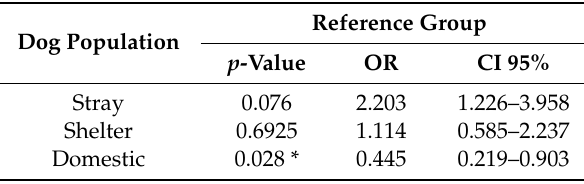
Table A3. Statistical analysis of association as per type of dog population (stray, shelter and domestic; breeding establishment dogs were considered as the reference group).